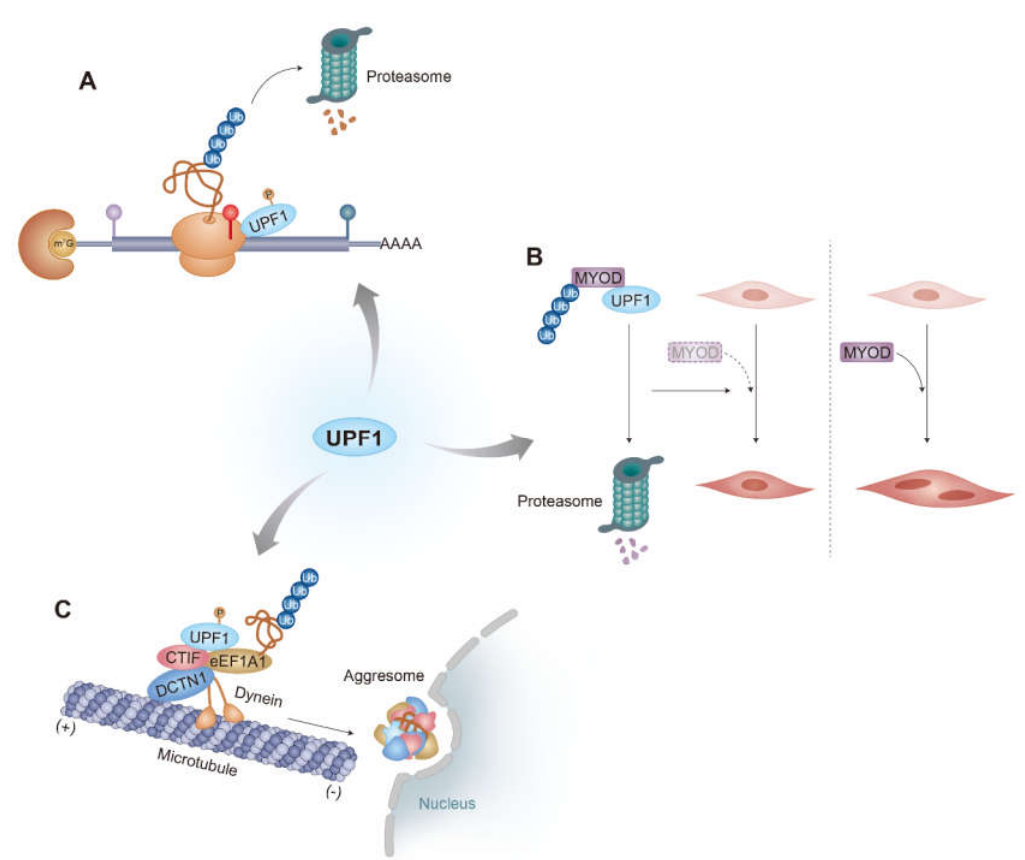
Figure 3. Diverse functions of UPF1 in protein quality control. ( A ) UPF1-driven degradation of PTC-polypeptides synthe- sized during NMD in yeast. Given its coupling to NMD, this function might be dependent on UPF1 hyperphosphorylation. The involvement of the E3 ligase ability of UPF1 and whether this mechanism works for PTC-polypeptides generated in mammalian cells remain to be determined. ( B ) UPF1-mediated degradation of properly folded proteins via the UPS. The E3 ligase activity of UPF1 is involved in ubiquitination of target proteins. A possible role of UPF1 hyperphosphorylation in this mode of protein degradation should be investigated. ( C ) UPF1-mediated degradation of misfolded polypeptides via the aggresome-autophagy pathway. UPF1 associates with the CED complex and misfolded polypeptides, ensuring their proper delivery to aggresomes. This mode of protein degradation is dependent on UPF1 hyperphosphorylation, but not on its E3 ligase activity.